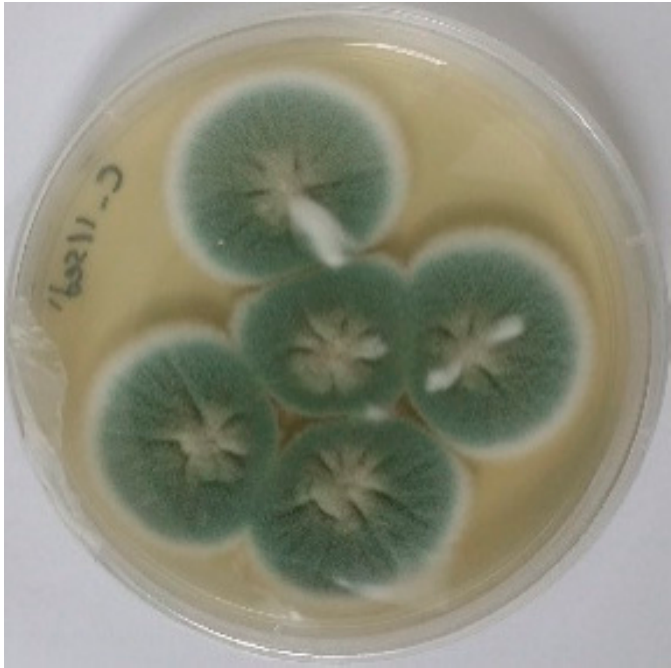
Figure 3. Morphological photo of the deep-sea-sediment-derived Penicillium chrysogenum strain